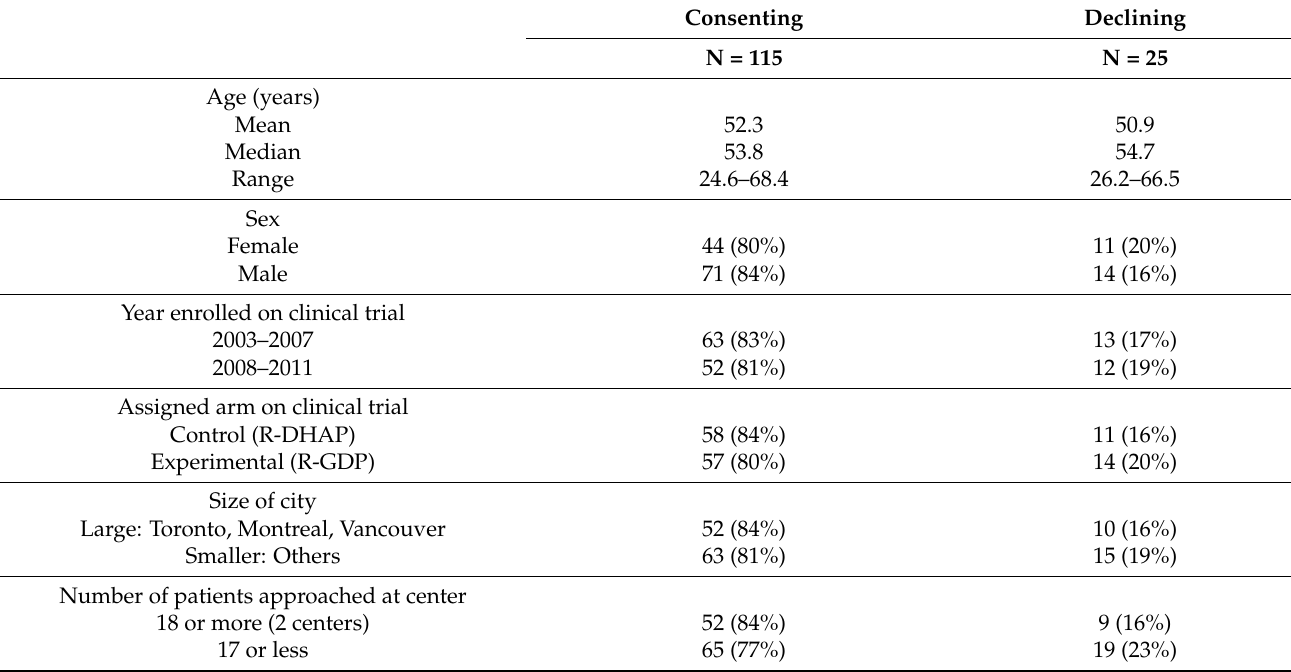
Table 2. Baseline characteristics among those consenting and not consenting to participate in the Long-term Innovative Follow-up Extension (LIFE)